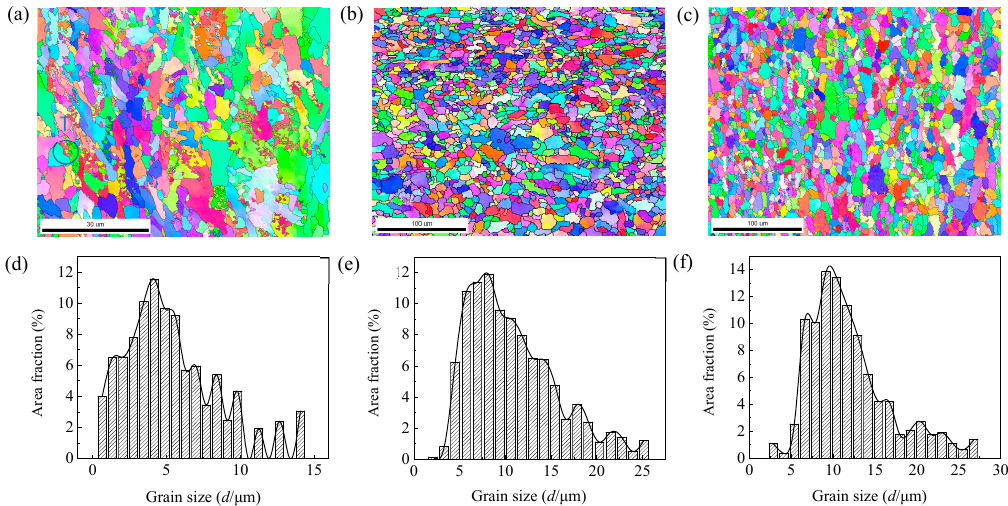
Figure 5. SEM images and EDS on 1/4 thickness sections of E36 ( a , d ), EH36 ( b , e ) and FH36 ( c , f ) steel plates.